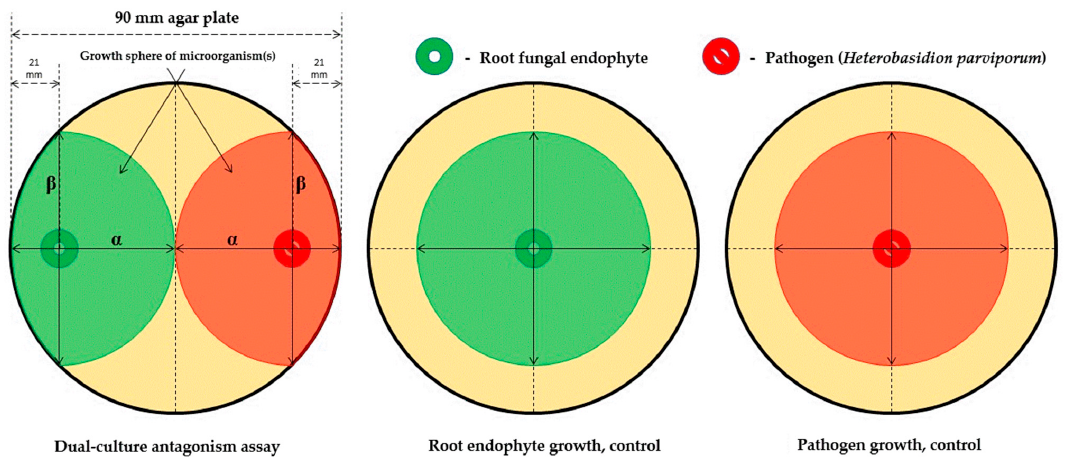
Figure 1. Schematic overview of the setup of the antagonism assay. The dual-culture antagonism assay tests the inhibitory e ff ect of the root fungal endophyte on the pathogen, Heterobasidion parviporum ; the inhibitory e ff ect is reflected in spherical index ( α / β ) of the respective organisms. Solitary cultures of the respective root endophyte and the pathogen were also plated—and observed—as controls in this experiment.